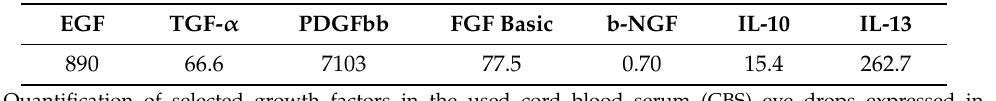
Table 1. Quantification of selected growth factors in